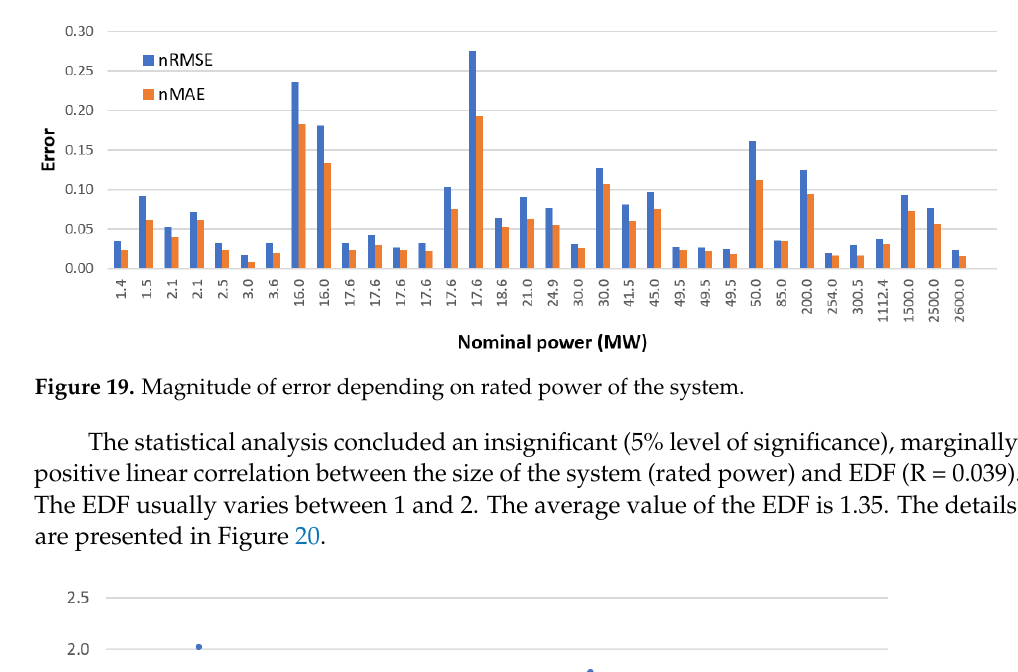
EDF (R = 0.039). The EDF usually varies between 1 and 2. The average value of the EDF is 1.35. The details are presented in Figure 20.